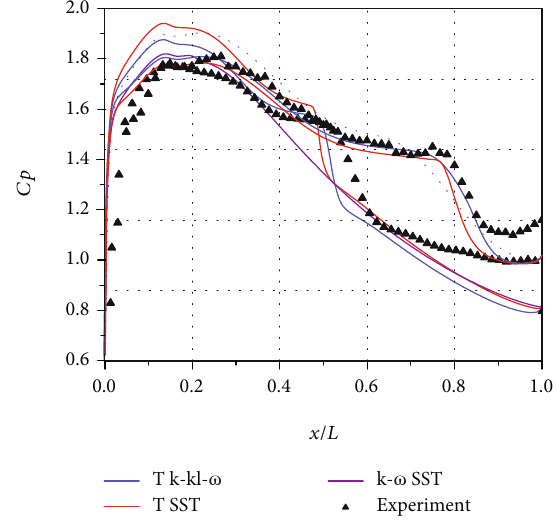
Figure 5: Turbulence model comparison in case D12-7 Re = 300000 Tu = 1 : 5